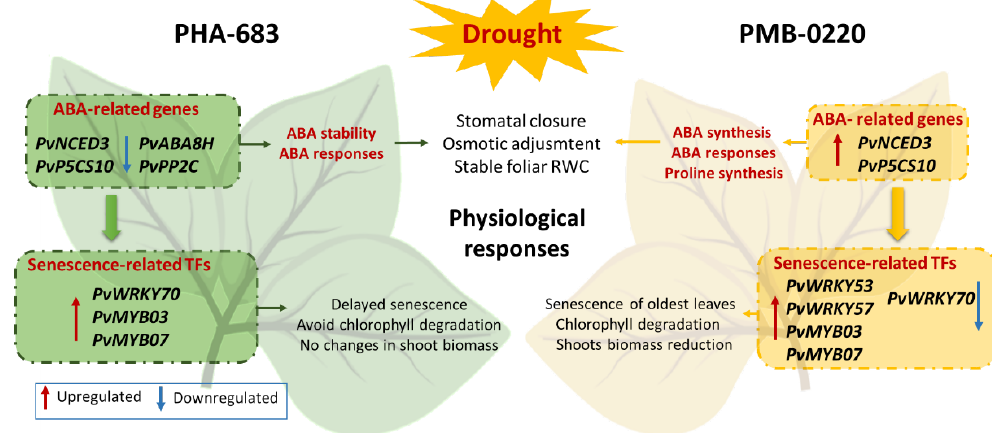
Figure 5. Schematic representation of gene expression patterns of key transcription factors related to senescence and drought responses in leaves from control and 10 days-drought-stressed PMB-0220 and PHA-0683 plants. Only key genes whose expression levels appeared as upregulated or downregulated with respect to control well-irrigated plants are shown.